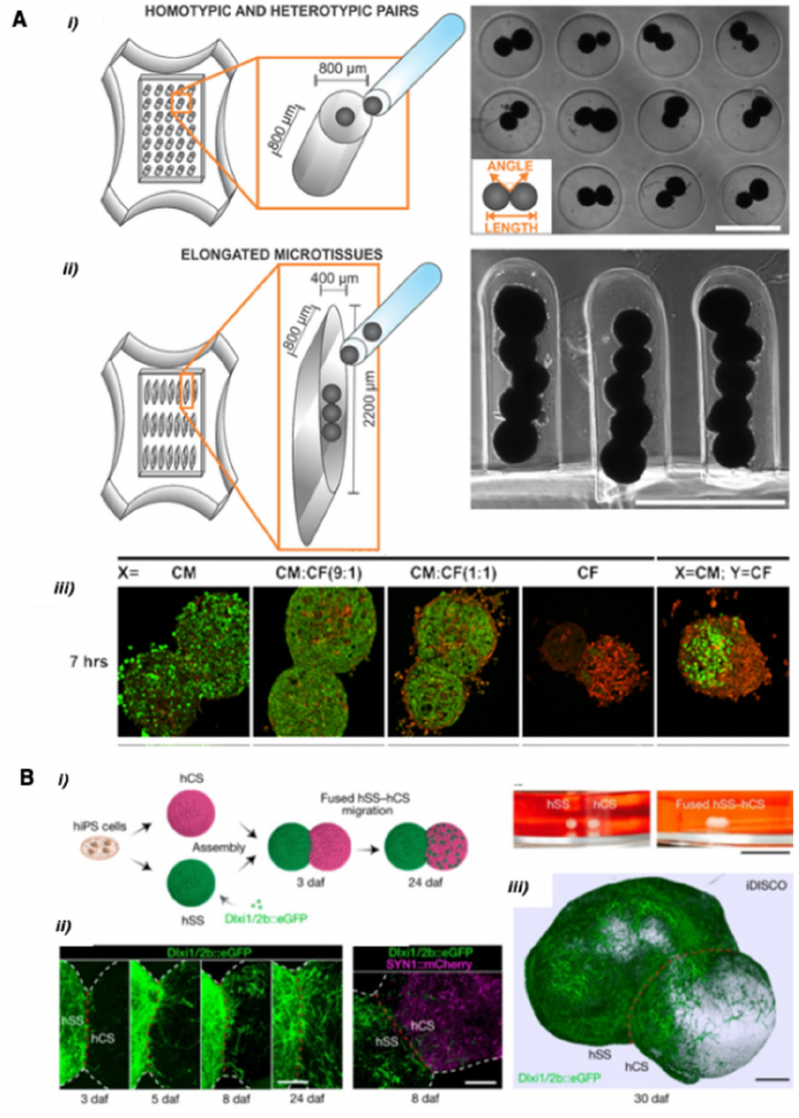
Figure 2. Directed assembly approaches. ( A ) Formation of cardiac spheroid pairs, and elongated microtissues. Cardiac fibroblasts (CF) and cardiomyocytes (CM) in suspension were co-seeded to the center of the hydrogel. (i) cylindrical microwells containing homotypic or heterotypic spheroid